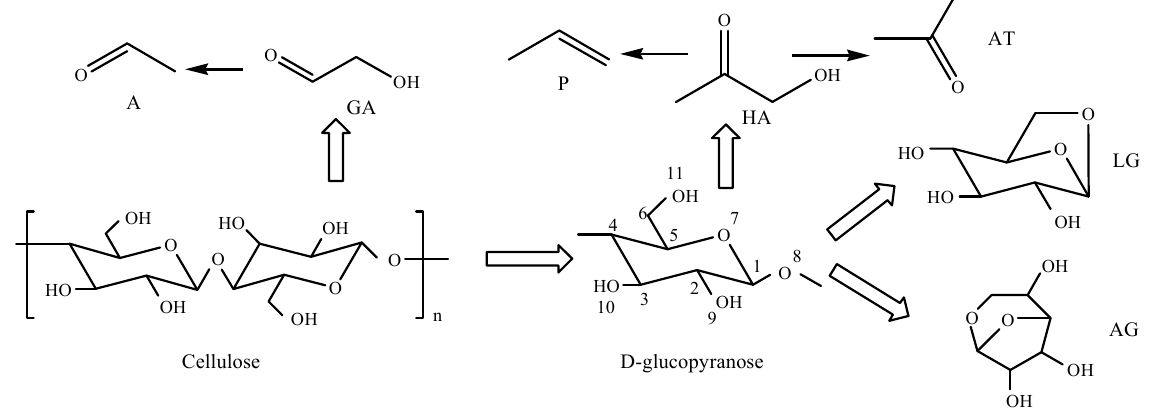
Figure 2. Proposed product formation pathway during cellulose pyrolysis.